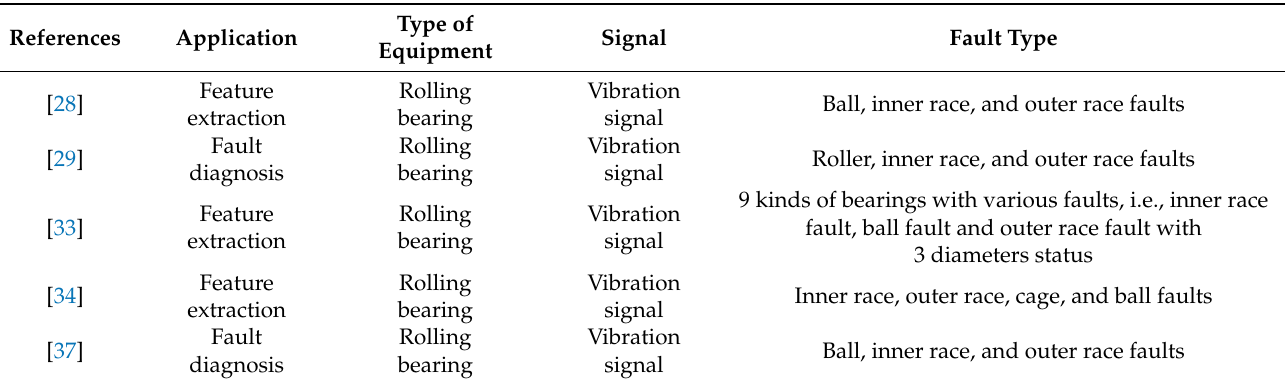
Table 3. Bearing condition monitoring using Fourier